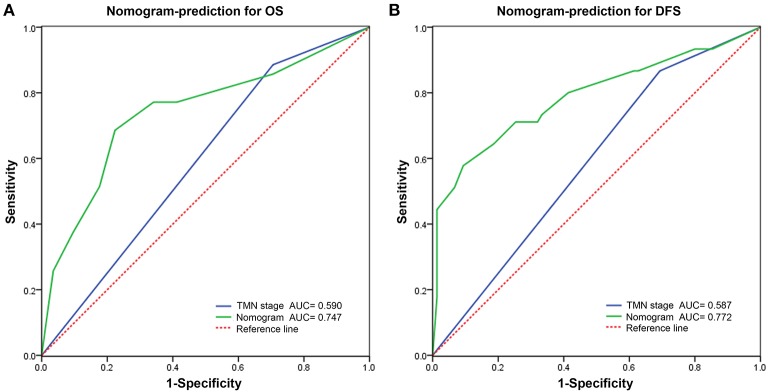
Predictive performance of nomogram compared with TNM stage for overall survival (A) and disease-free survival (B) by receiver operating characteristic (ROC) curve analysis.